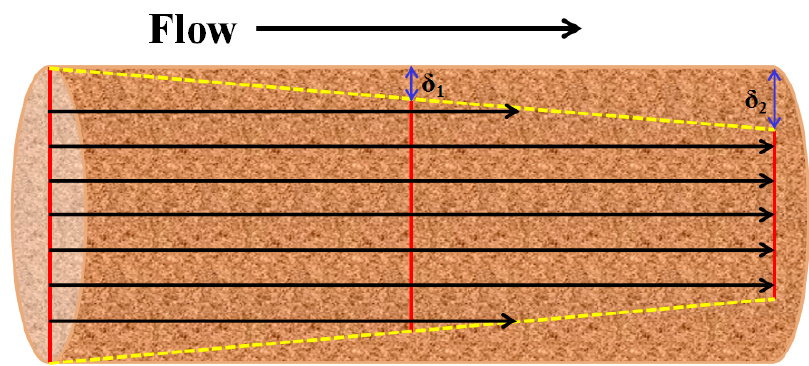
Figure 6. Changes of the boundary layer thickness while flowing ( δ 2 > δ 1 ).